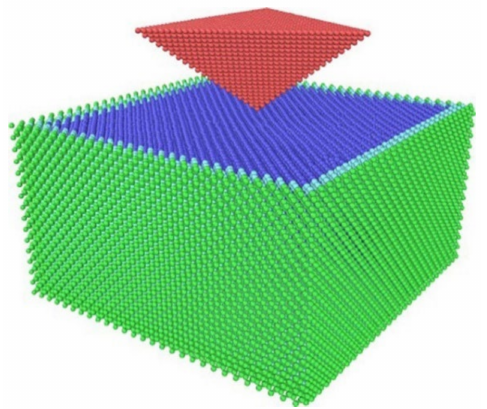
Figure 1. Simulation model of (100) crystal plane